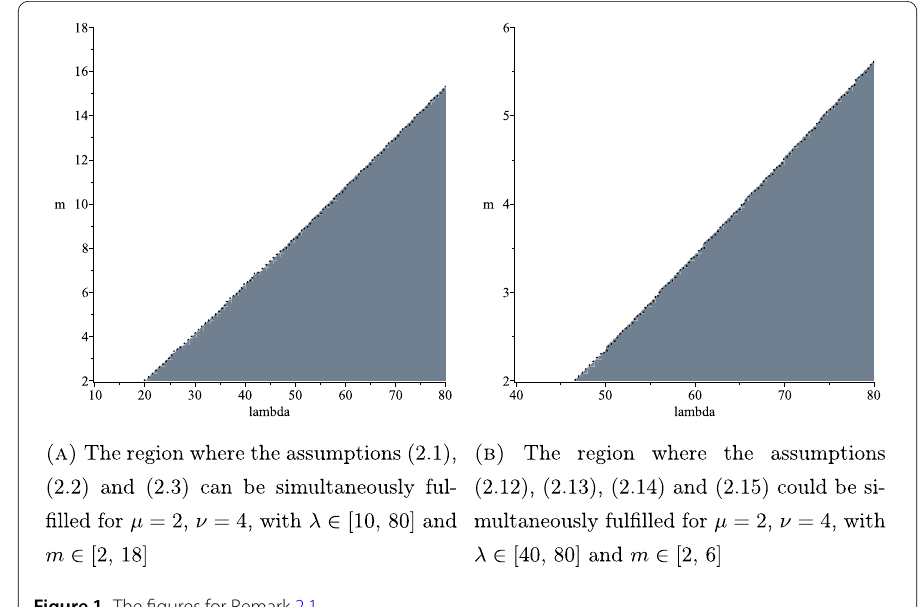
Figure 1 The figures for Remark